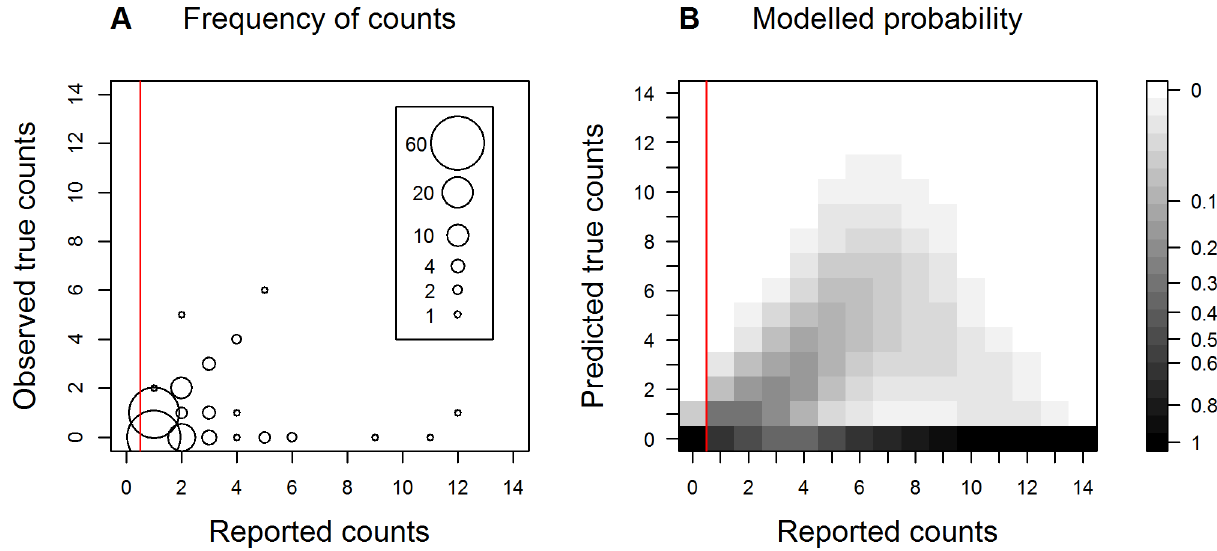
Figure 4. Quantified bias of the citizen science data of counts of parasitoids. (A) The observed frequency of the true number of parasitoids against the reported number, which was determined from samples retained from participating school children. Frequencies are not shown when the reported number of parasitoids was equal to zero (to the left of the red vertical line). (B) The probability distribution of the true number of parasitoids against the reported number, based on a zero-inflated Poisson regression of a subset of validated records. To the left of the red vertical line the probabilities were directly calculated, while to the right they were estimated from the model.